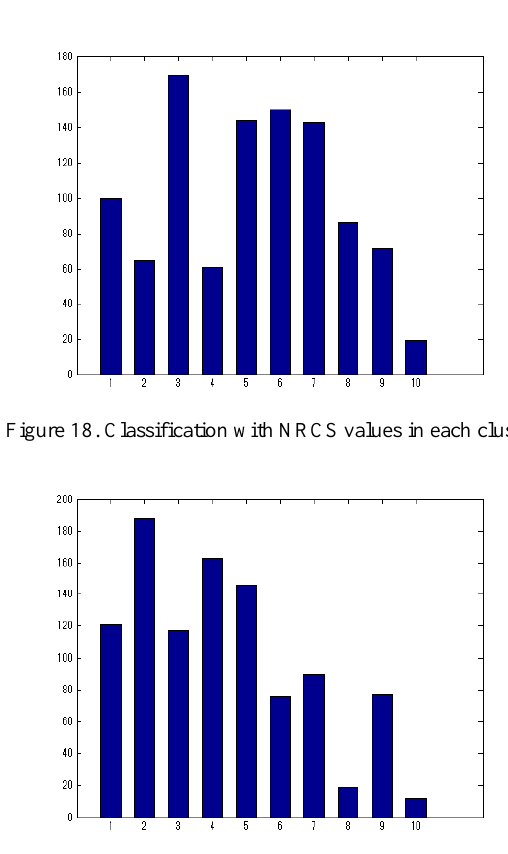
Figure 19. Classification with NRCS and the number of roof segments in each cluster